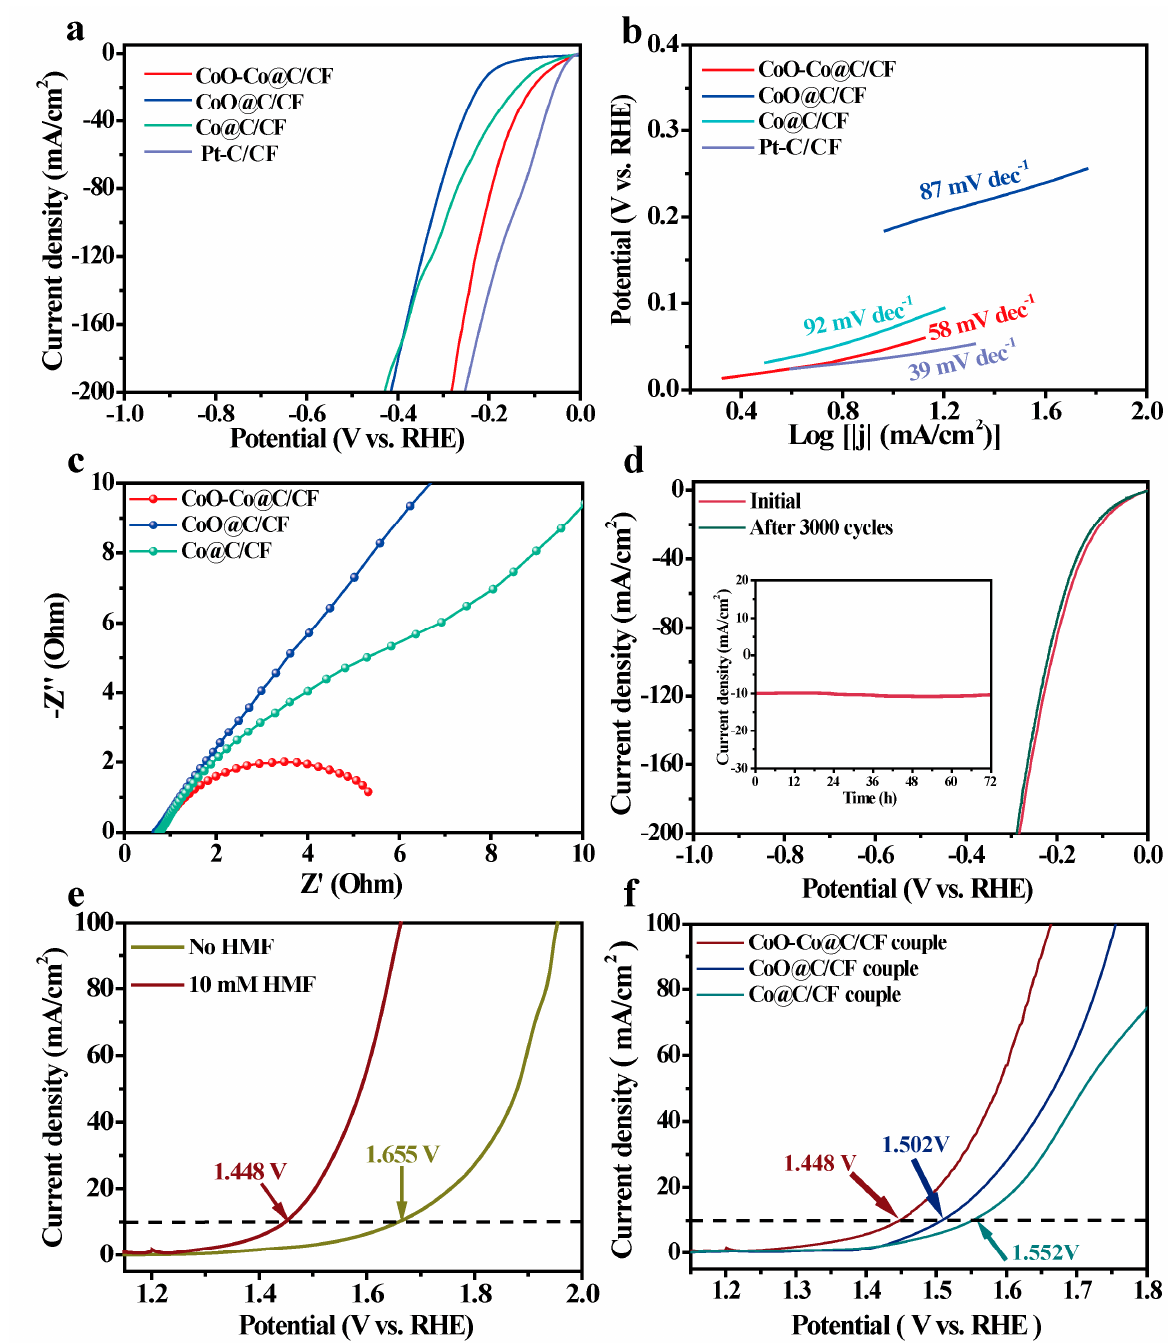
Figure 5. ( a ) iR-compensated polarization curves and ( b ) Tafel slopes of HER over CoO–Co@C/CF, CoO/CF, Co/CF, and Pt − C/CF in 1.0 M KOH at a scan rate of 5 mV · s − 1 . ( c ) Nyquist plots at 0.080 V vs. RHE of CoO–Co@C/CF, CoO@C/CF, Co@C/CF, and Pt − C/CF in 1.0 M KOH. ( d ) Polarization curves of CoO–Co@C/CF before and after 3000 cycles (Inset: I-t curve of CoO–Co@C/CF at η 10 for 72 h). ( e ) Polarization curves of CoO–Co@C/CF||CoO–Co@C/CF systems in 1.0 M KOH with/without 10 mm HMF. ( f ) Polarization curves of CoO–Co@C/CF, CoO@C/CF, and Co@C/CF couples in 1.0 M KOH with 10 mM HMF.